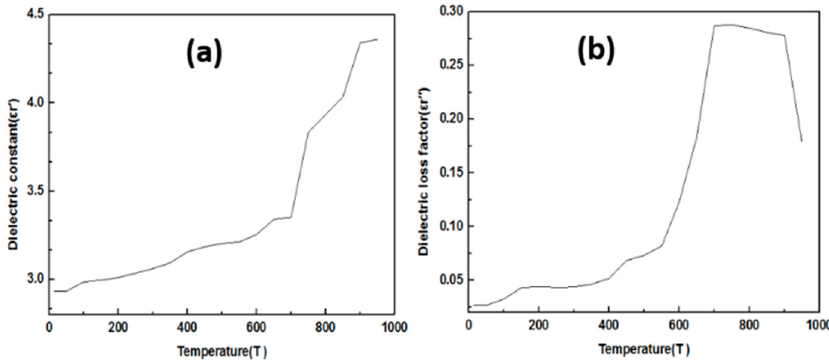
Figure 7. Dielectric constant ( a ) and loss factor ( b ) of Na 2 CO 3 with temperature.